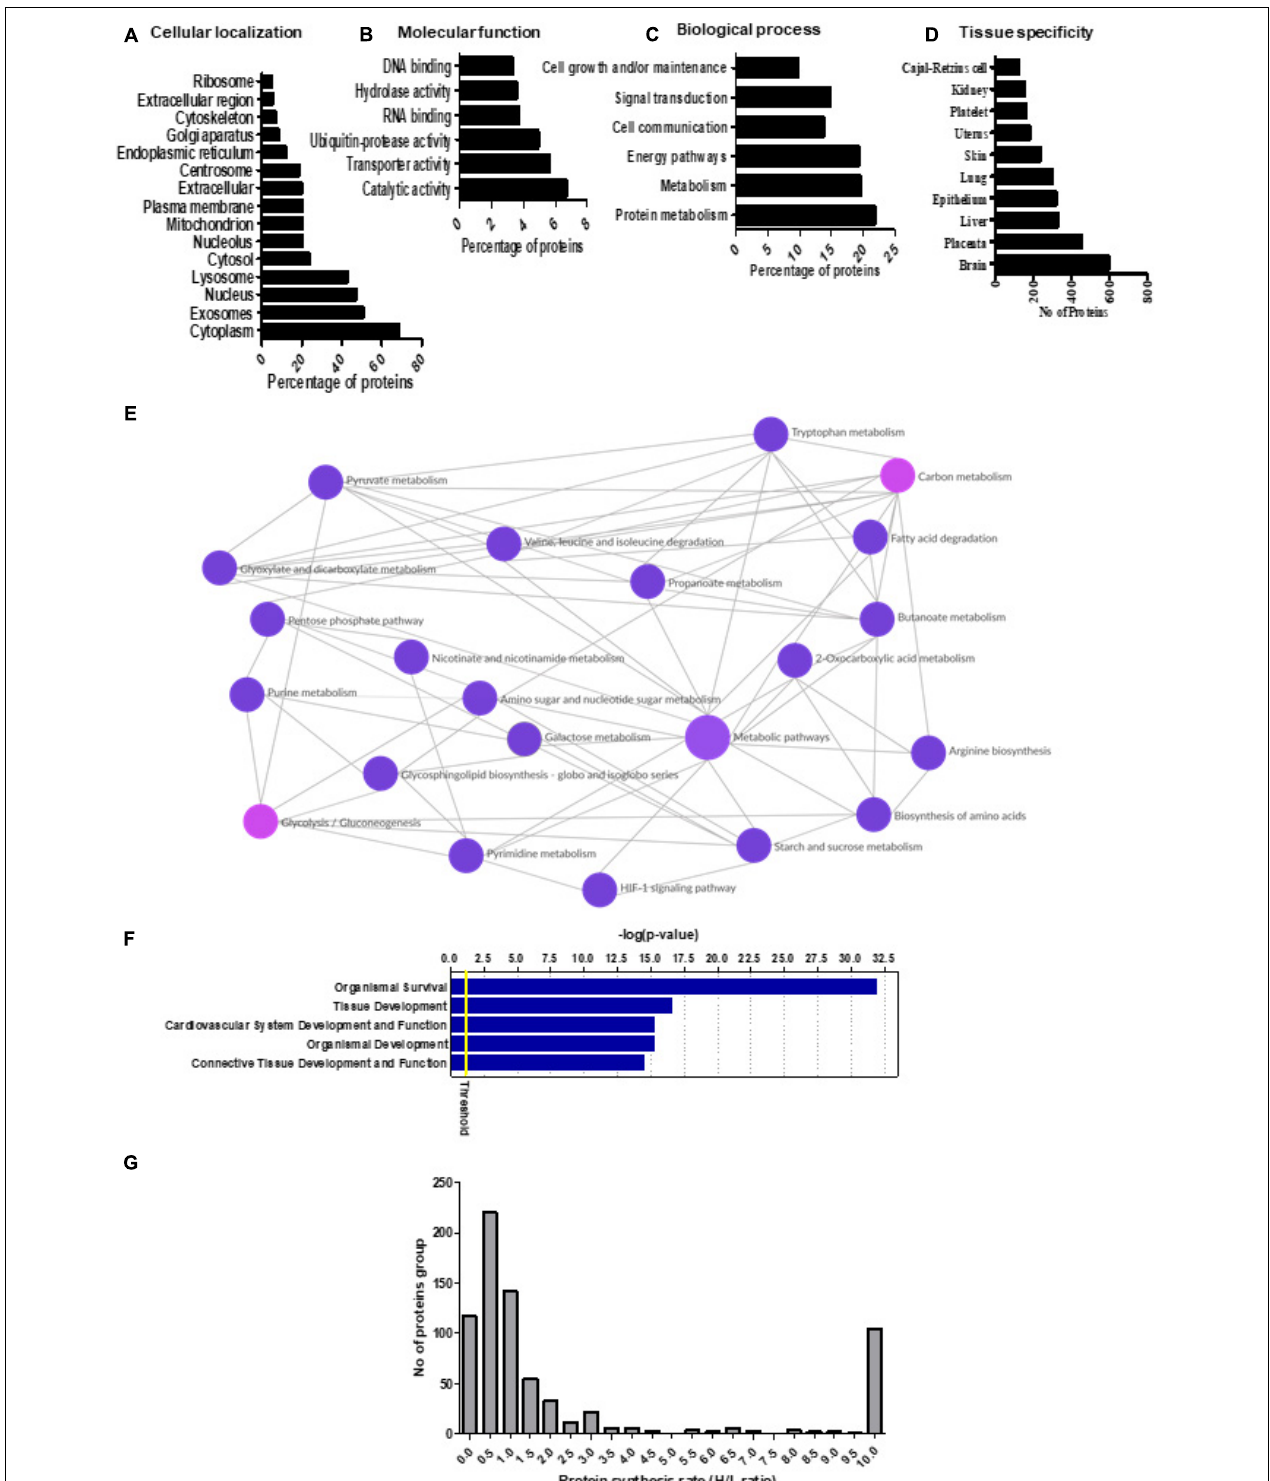
FIGURE 1 | (A–D) Gene ontology and Kyoto Encyclopedia of Genes and Genomes (KEGG) pathway analysis of the primary human trophoblast (PHT) secretome. The proteins identified in the PHT secretome were analyzed by Functional Enrichment Analysis Tool (www.funrich.org), which provides prediction of subcellular localization prediction software to predict the (A) cellular localization, (B) molecular function, and (C) biological processes of proteins in the secretome. (D) The